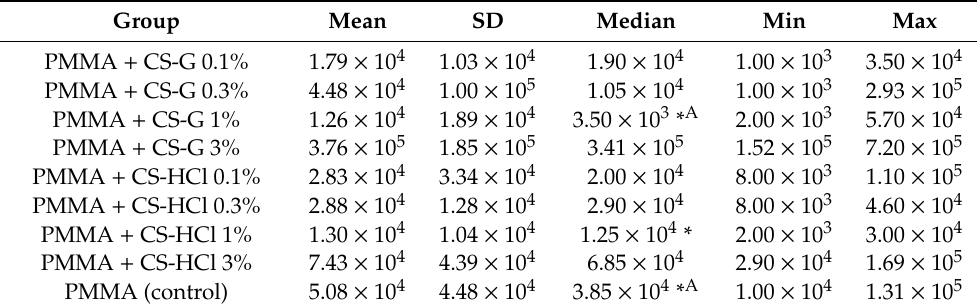
Table 1. Descriptive data for C. albicans cell counts per 1 cm 2 .